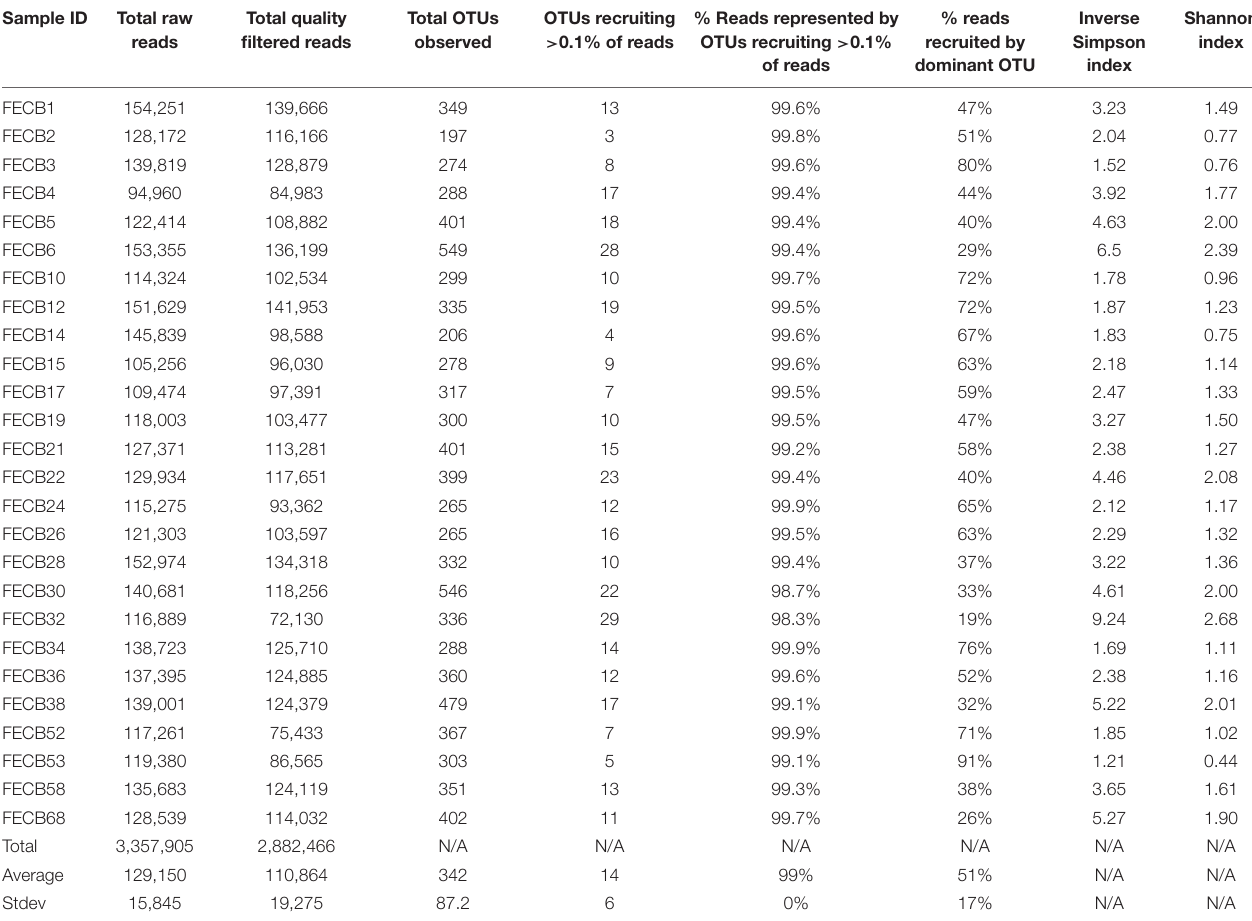
TABLE 2 | Read statistics and diversity Index for co-cultures investigated in this study. Sample